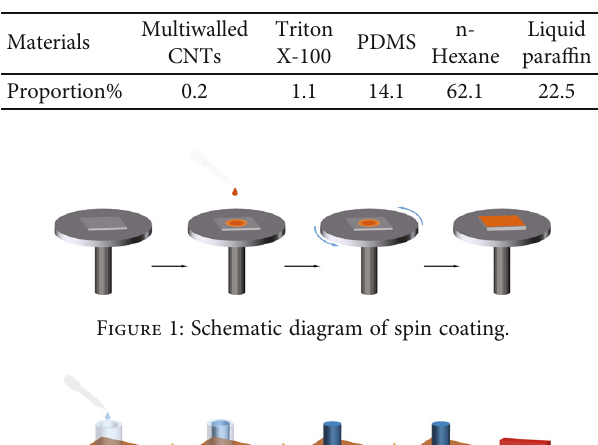
Table 1: The materials of CNT nanocomposite photothermal coating.